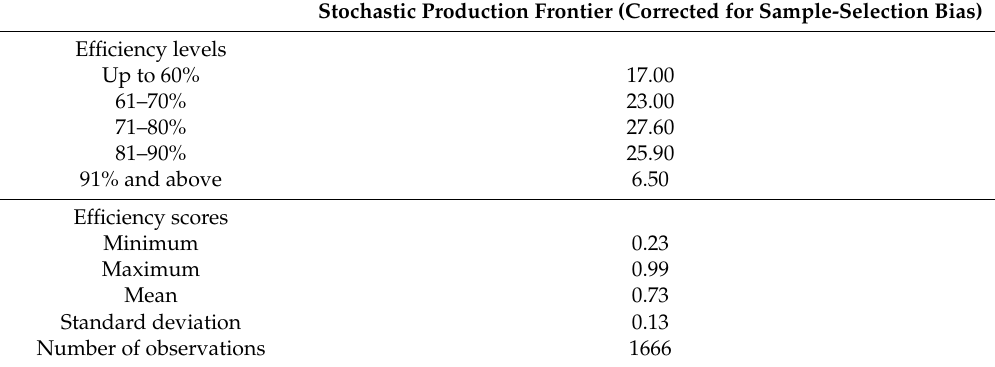
Table 7. Distribution of technical efficiency scores of improved pulse